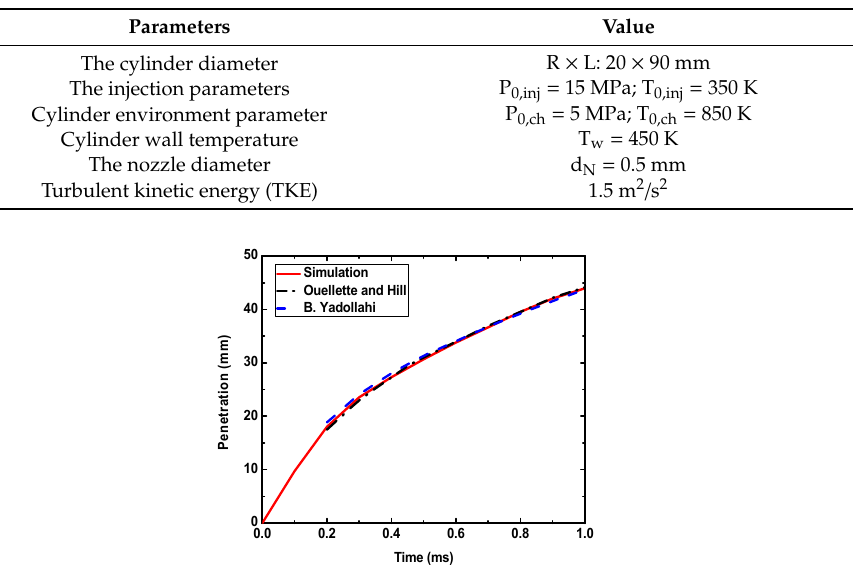
Table 5. Validation of relevant parameters for jet model.